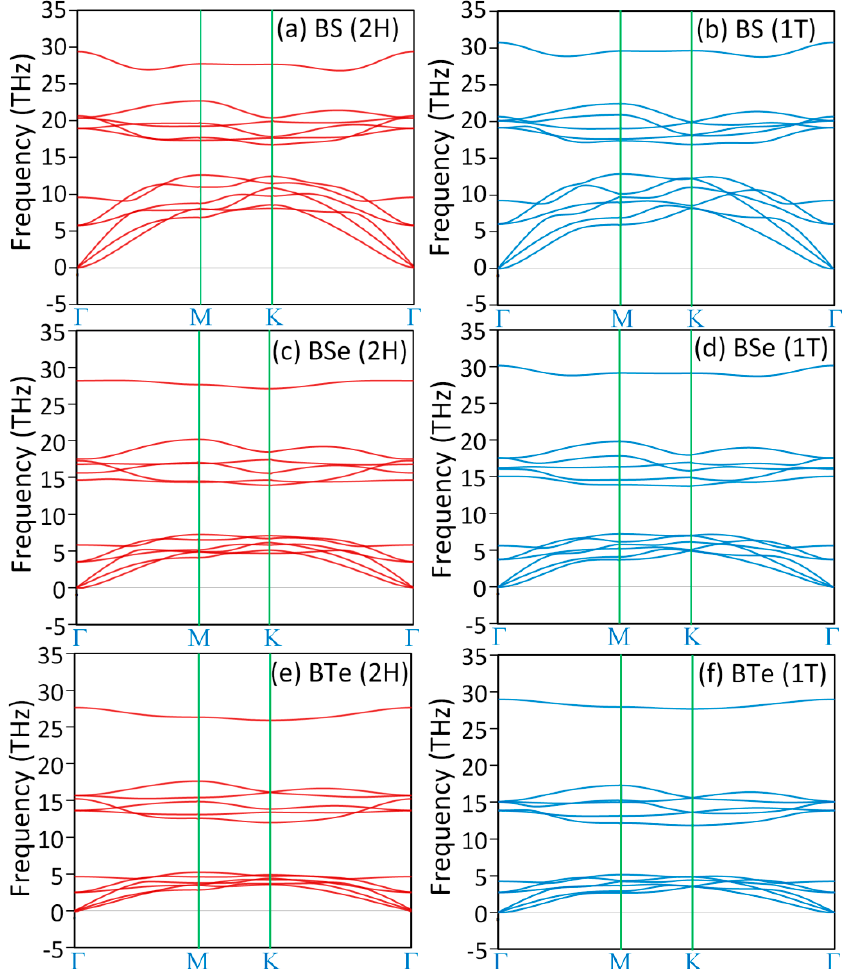
Figure 2. Phonon dispersions of free-standing and single-layer BX nanosheets.